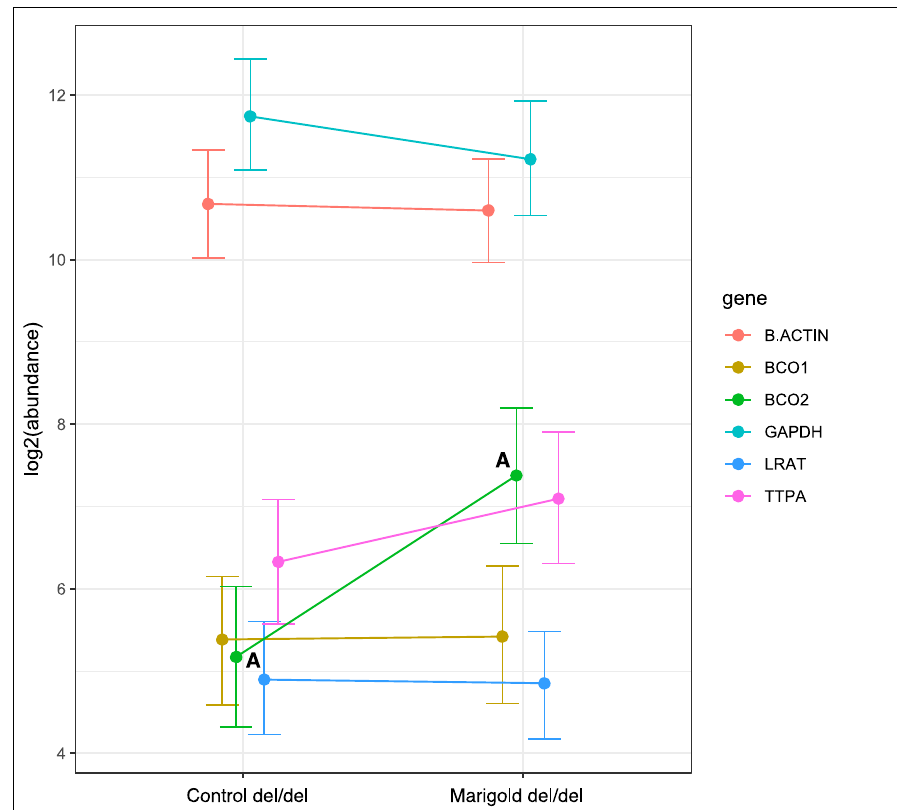
Figure 2. Relative BCO1 , BCO2 , LRAT , and TTPA mRNA levels in the liver of rabbits with different genotypes at codon 248 of the BCO2 gene (ins/ins vs. ins/del vs. del/del) fed a diet with the addition of Aztec marigold flower extract. GAPDH and ß-actin were used as reference genes. Data represent posterior means (expressed as arbitrary units) ± 95% credible intervals. Means followed by the same superscripts (a, a) differ significantly ( p ≤ 0.05).